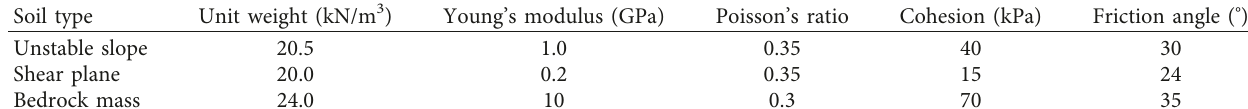
Table 1: Properties of soils used in the verification model.